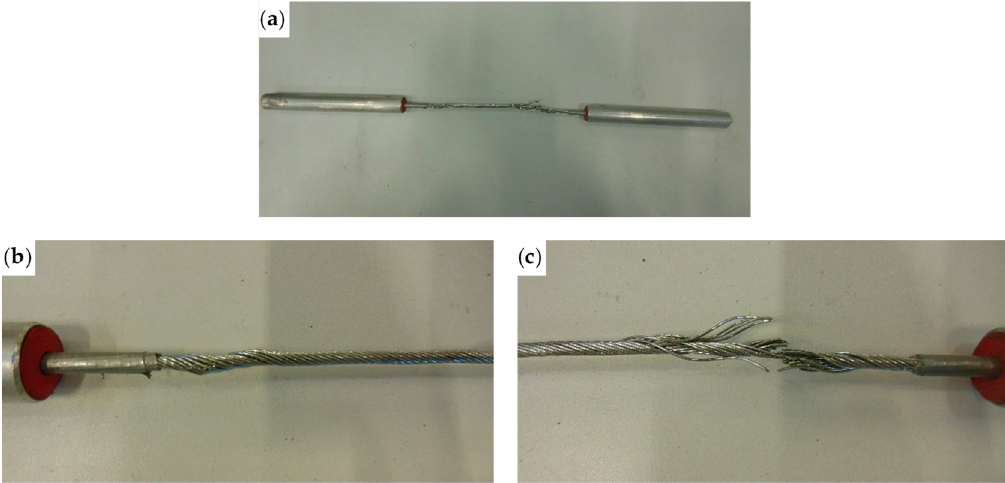
Figure 21. The spiral strand rope after the test: ( a ) general overview; ( b ) detail of wire twisting at the left end; and ( c ) detail of the failure due to fraying, at the right end.